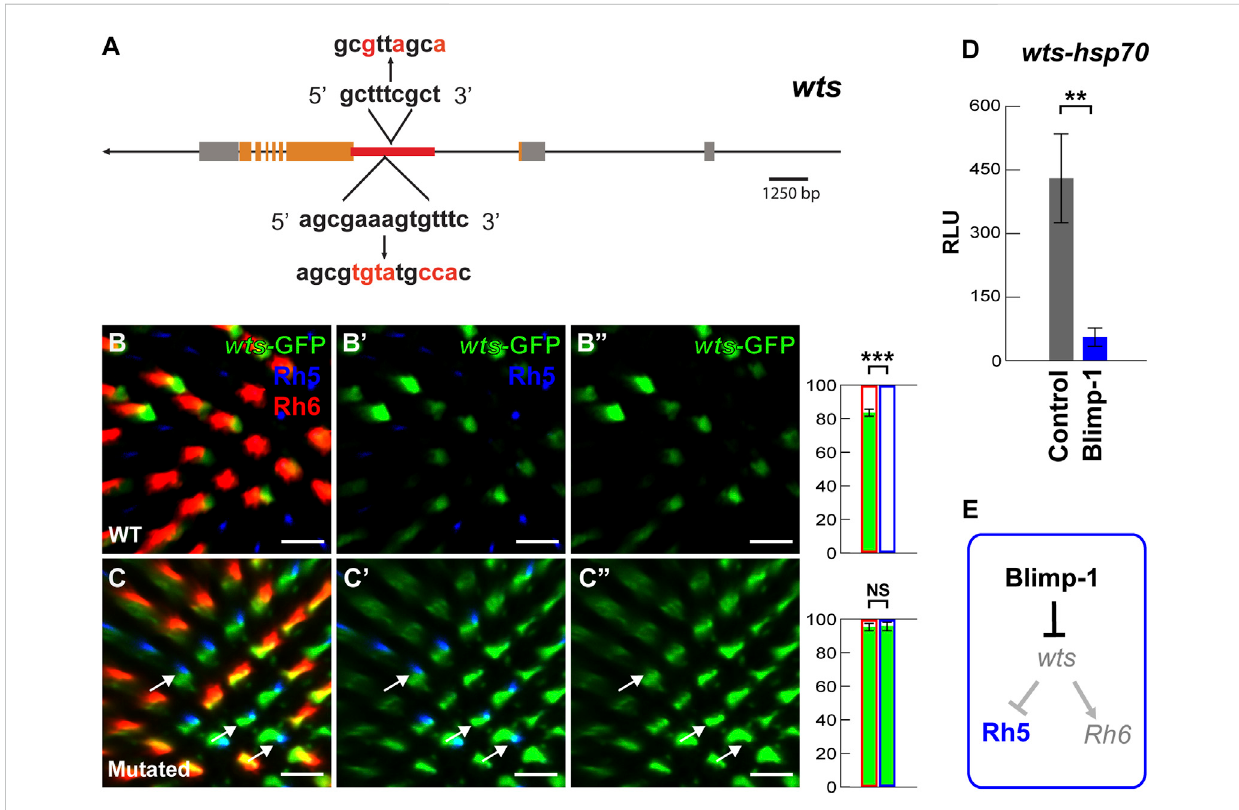
Blimp-1 represses the warts intronic enhancer. (A) Schematic of the wts locus. The red line indicates the location of the 2.6 kb wts enhancer in the second intron that contains two conserved Blimp-1 motifs. The red letters indicate introduced mutations. (B – B ’ ) The 2.6 kb wts enhancer fused to an hsp70 promoter drives GFP (hereafter referred to as wts- GFP reporter) in the majority of Rh6 photoreceptors. Right: percentage of Rh6 photoreceptors (red outline) or Rh5 photoreceptors (blue outline) that co-express GFP (green bars), respectively. %Rh6/GFP co-expression vs. %Rh5/GFP co- expression was compared with an ANOVA and a post hoc Tukey HSD Test; *** p < 0.0001. N = 5 retinas. (C – C ’ ) Mutation of the two conserved Blimp-1 motifs causes wts- GFP reporter de-repression in Rh5 photoreceptors. White arrows indicate examples of wts- GFP de-repression. Right: percentage of Rh6 photoreceptors or Rh5 photoreceptors that co-express GFP, respectively. N = 5 retinas. All scale bars, 10 µm. (D) Dual luciferase reporter assay. The intronic wts reporter ( wts-hsp70-luc ) is active in S2 cells, but Blimp-1 strongly represses it ( N = 3). Y -axis: Relative Luminescence Units (RLU) of wts- hsp70-luc normalized to the Renilla luciferase control reporter (see Materials and methods). (E) Schematic of Blimp-1 function in color photoreceptor speci fi cation: Blimp-1 represses wts /Rh6 fate to promote Rh5